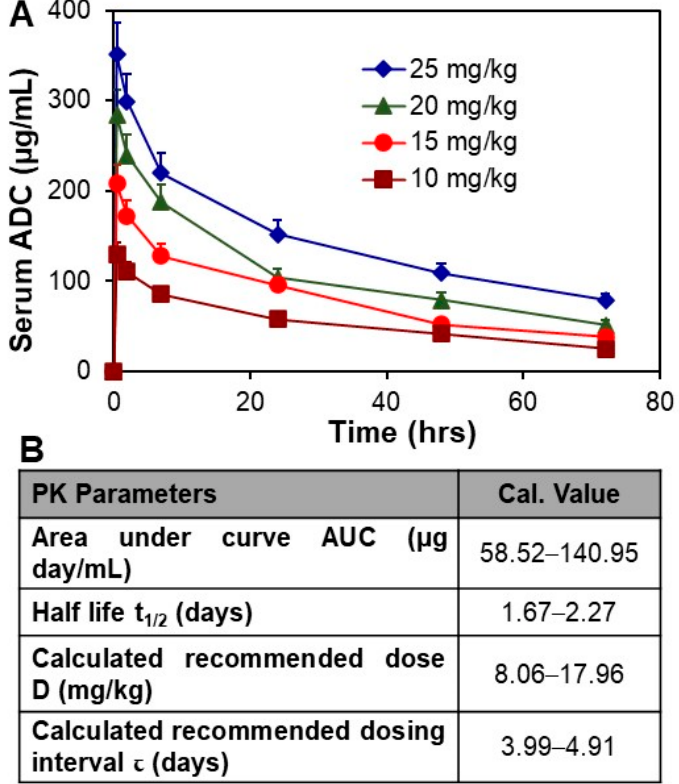
Figure 4. PK study of ADC. ( A ) Analysis of circulation stability by PK, n = 3. ( B ) The representative PK modeling parameters of ADC. Data represented as mean ± SEM.